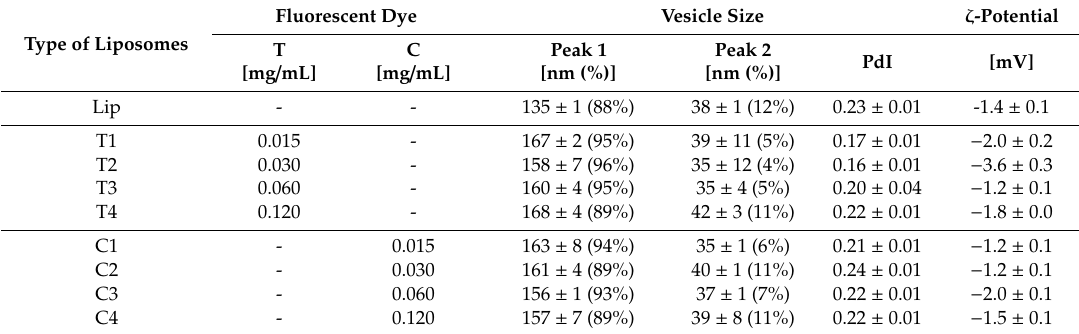
Table 1. Characteristics of freshly prepared liposomal